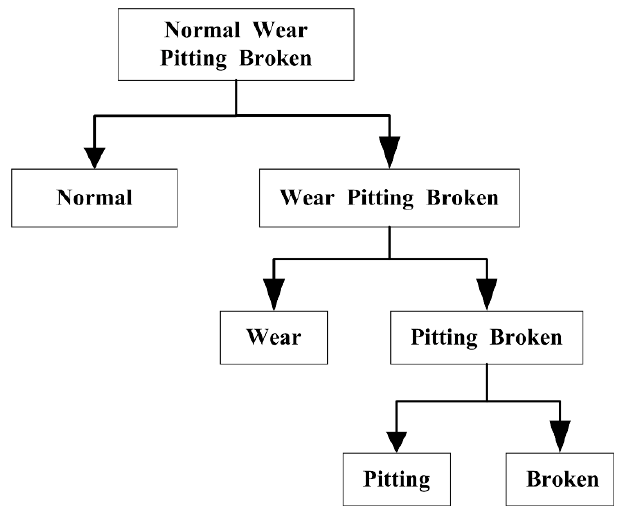
Figure 1. Four-class SVM recognition flow chart for gearbox fault diagnosis.